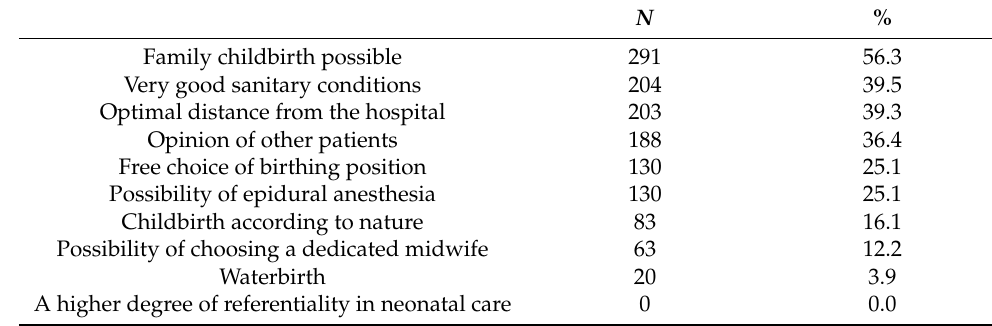
Table 2. The results of the frequency analysis for the answer to the question “Choose the 3 most important factors that affect your choice of the place of